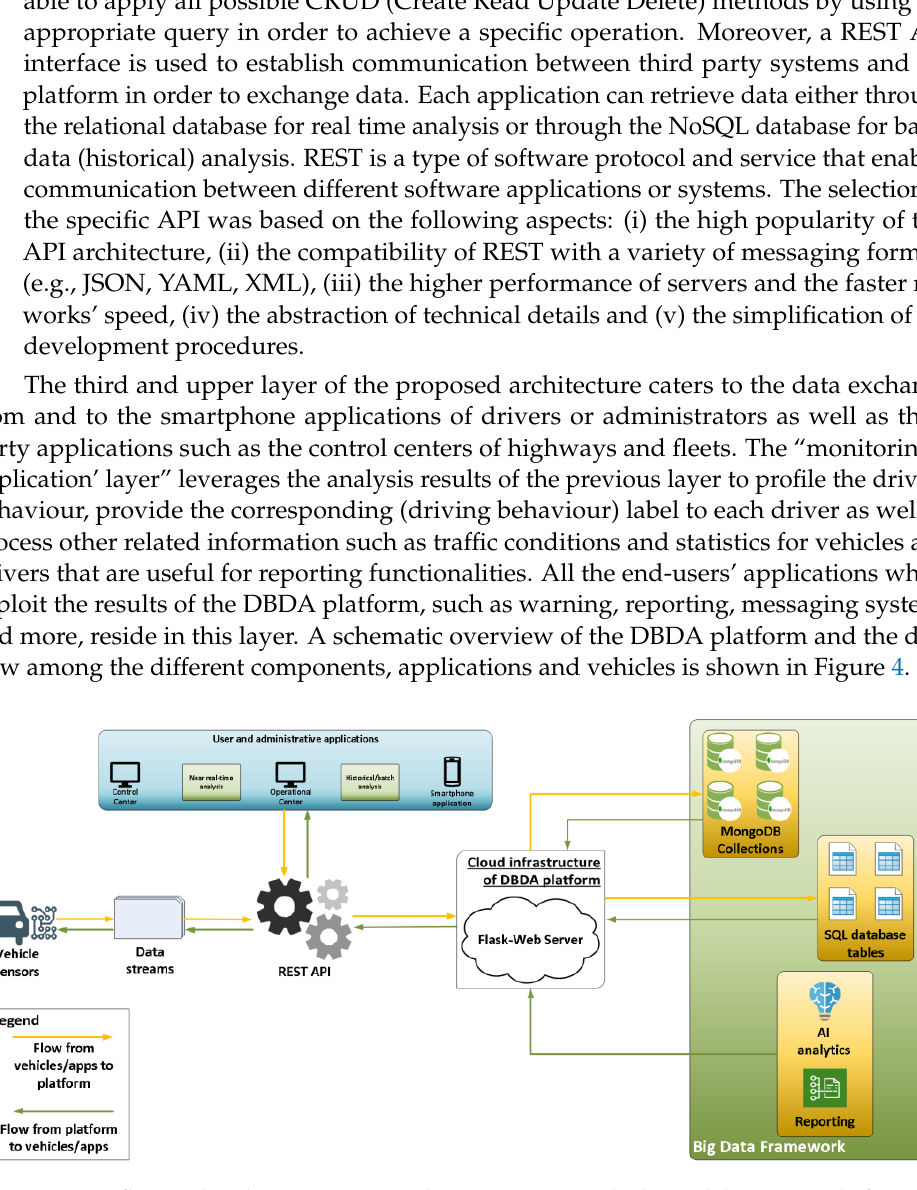
Figure 4. Data flow and exchange among applications, sensor vehicles and the DBDA platform.